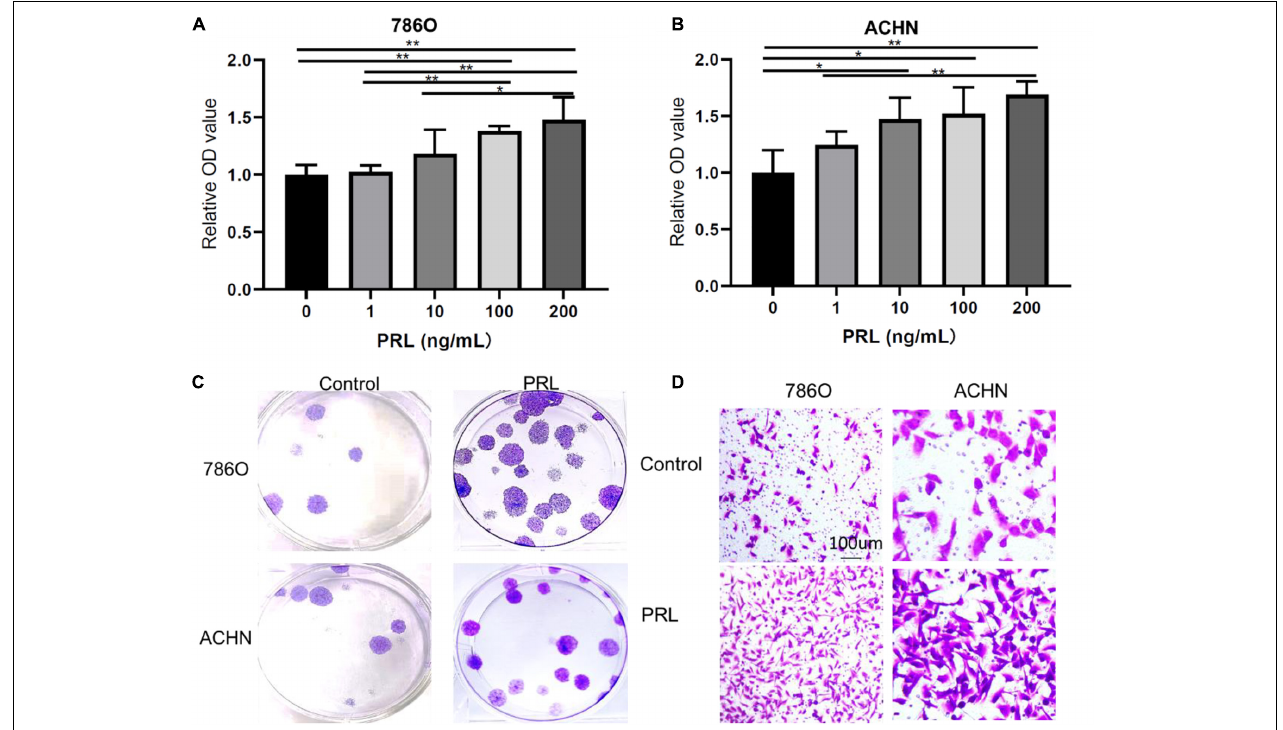
FIGURE 4 | Overexpression of PRL in ccRCC. (A) Prolactin can stimulate the proliferation of the 786O cell line. (B) Prolactin can stimulate the proliferation of the ACHN cell line. (C) Prolactin treatment promotes the clonality of the 786O and ACHN cell lines. (D) Prolactin treatment promotes the migration of the 786O